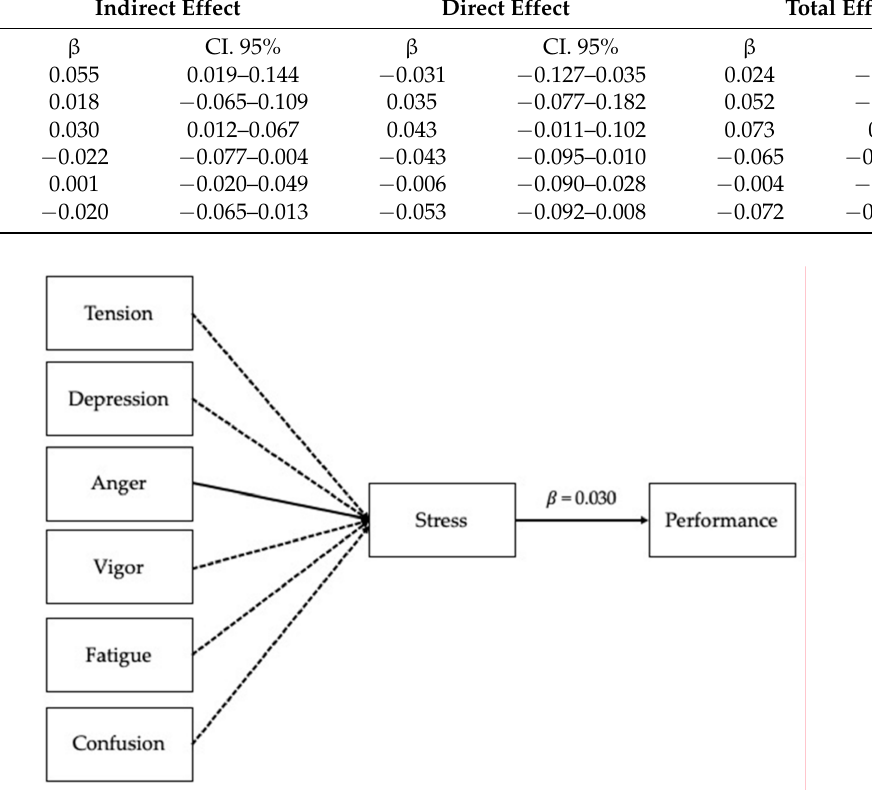
Figure 2. The mediation model. Note: Dashed lines indicate non-significant